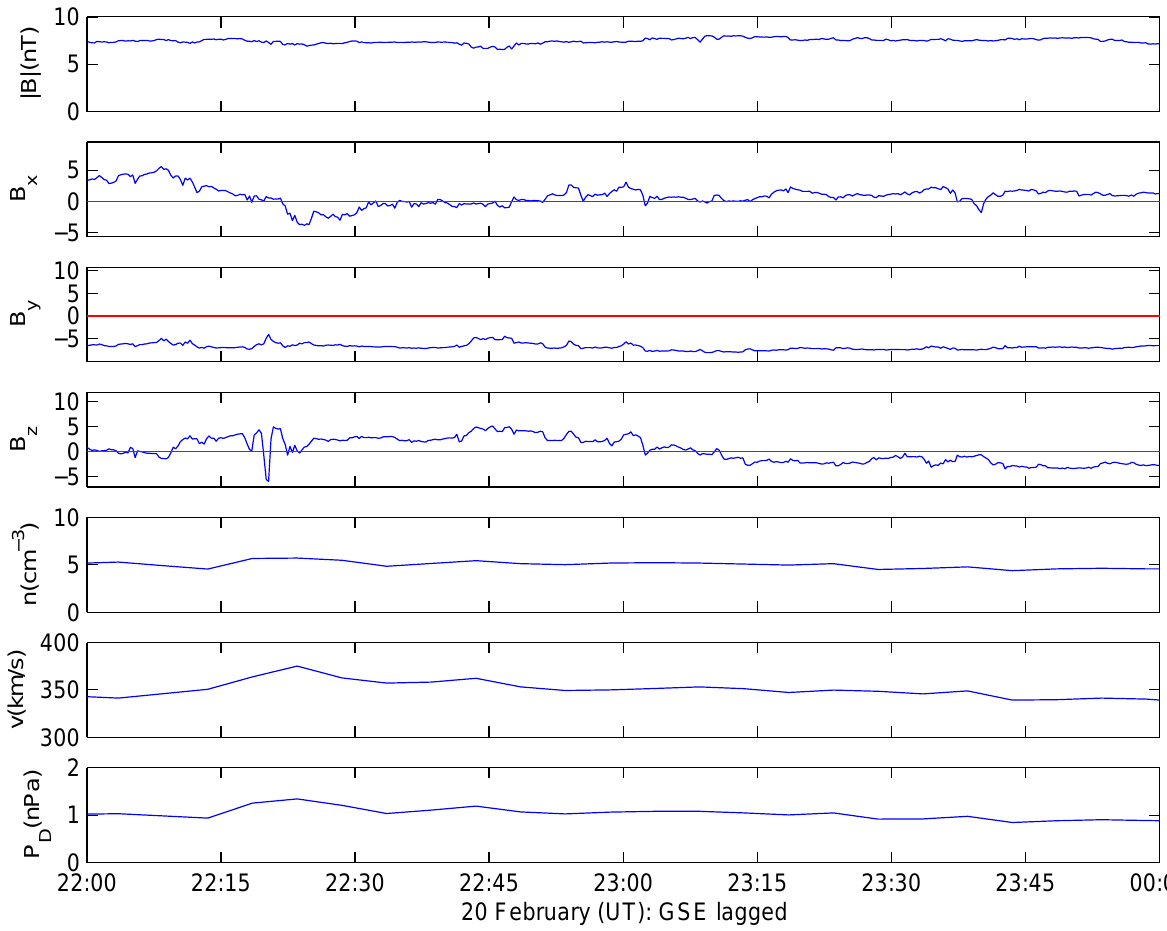
Fig. 10. Data from the ACE spacecraft located in the solar wind between 22:00 and 23:59 on 20 February 2001. A constant lag speed of 350km/s has been used. The format is the same as Fig. 3.